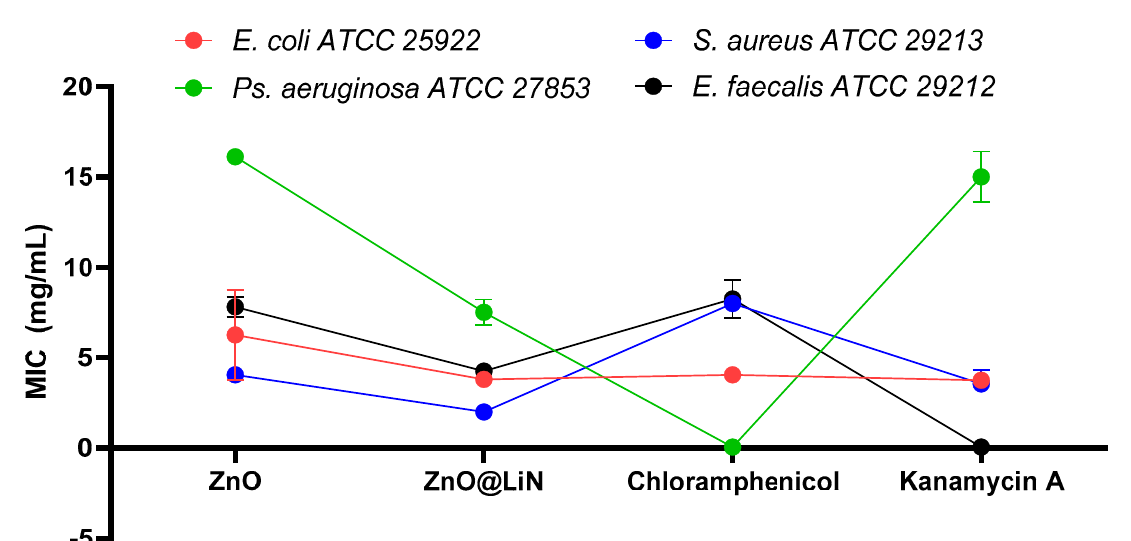
Figure 17. Comparison of MIC values of ZnO-based nanoparticles and genera use antibiotics against strains of E. coli , P. aeruginosa , S. aureus , and E. faecalis .